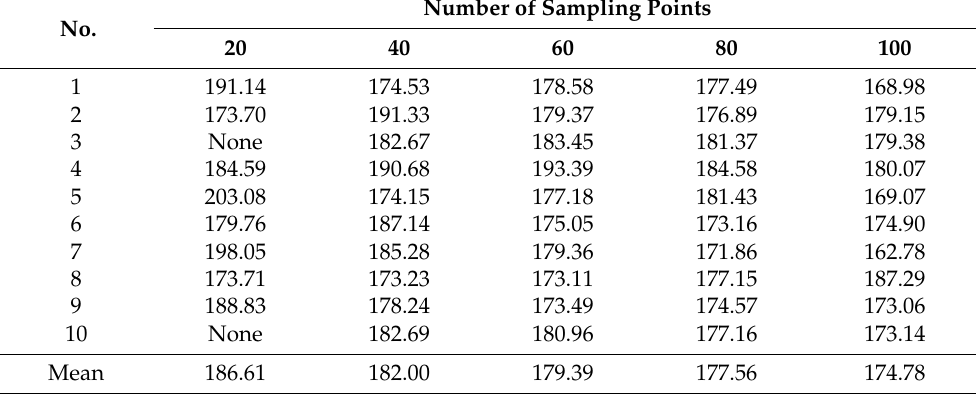
Table 4. Path distance using